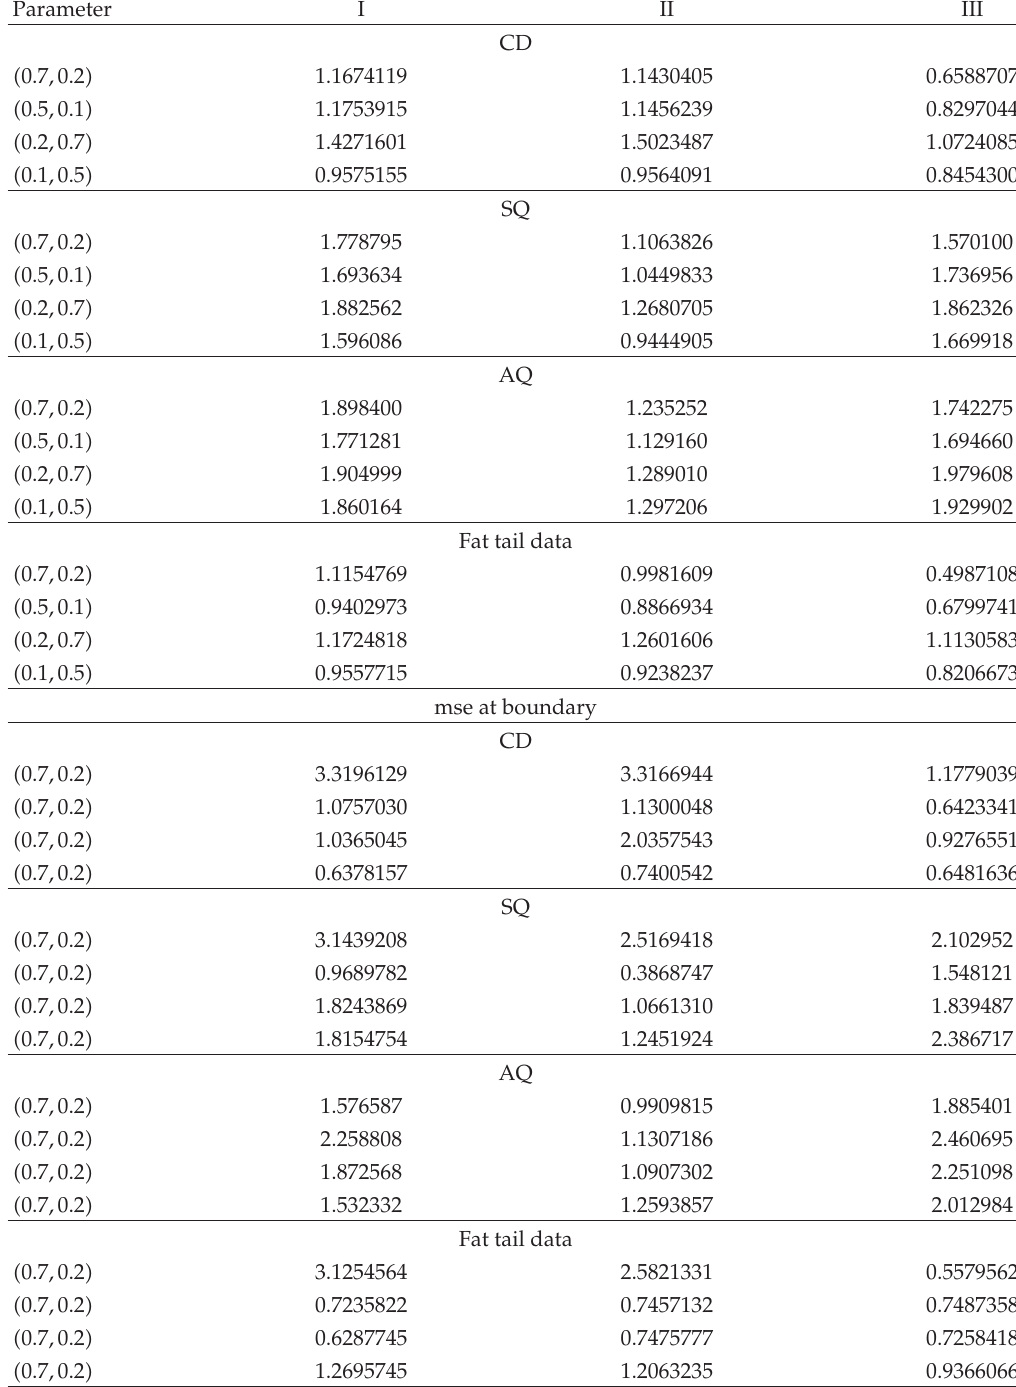
Table 4: Simulation results of global and local mean squared using AR (cid:5) 2 (cid:6) with di ff erent parameters. The first half of the table displays the global mean squared